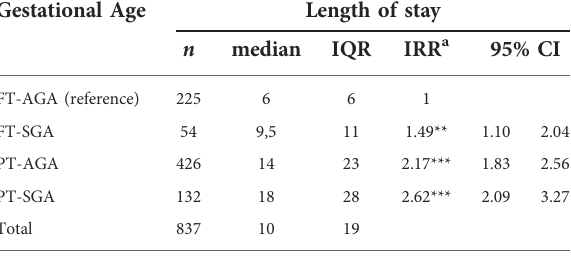
TABLE 3 Effect of small for gestational age on length of hospital stay among respiratory distress.